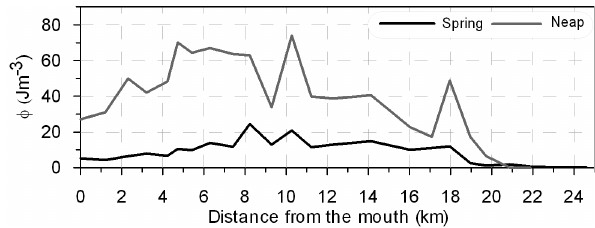
Fig. 11. Spatial variation of median estuarine parameter ( ν) during spring and neap tides along the Sumjin River Estuary. For ν ∼ 1, up- estuary transport of salt entirely by tide-driven mixing. For ν ∼ 0, up-estuary salt transport almost entirely by gravitational circulation. For 0.1 <ν < 0.9, both gravitational circulation and tide-driven cir- culation contribute to transporting salt up-estuary.